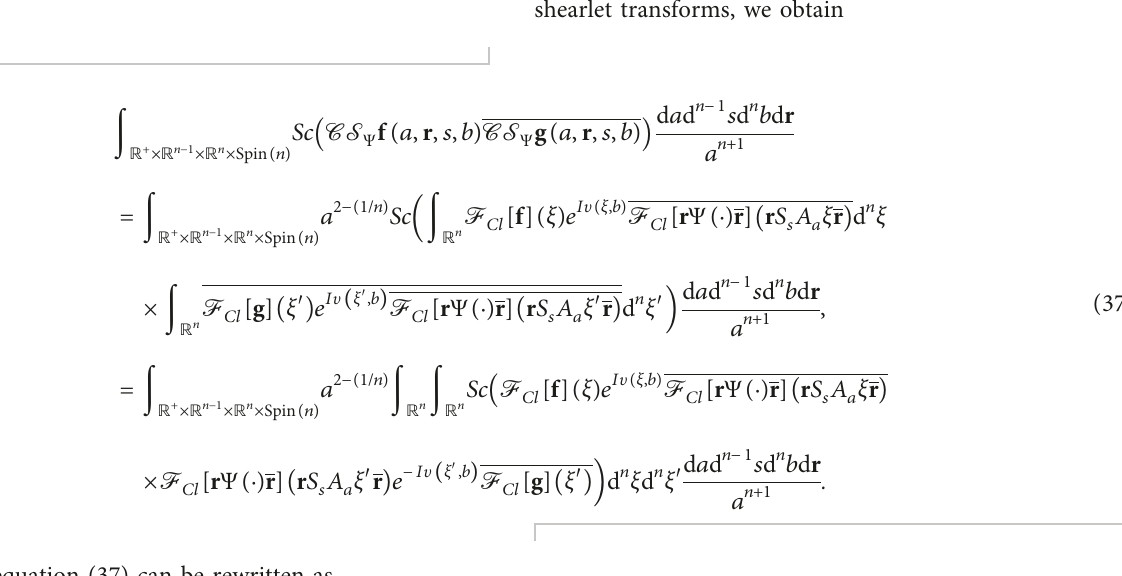
Figure 2: Two-dimensional Clifford-valued shearlet transforms of f ( x ,x ) given by equation (35). (a) Clifford-valued STof f at a � 1/2, b � 1, and s � 1/2. (b) Clifford-valued STof f at a � b � 1, and s � 1. Ψ r a,s,b ( x 1 2 (c) Contour plot of Clifford-valued ST of f at a � 1/2, b � 1, and s � 1/2. (d) Contour plot of Clifford-valued ST of f at a � b � 1, and s �